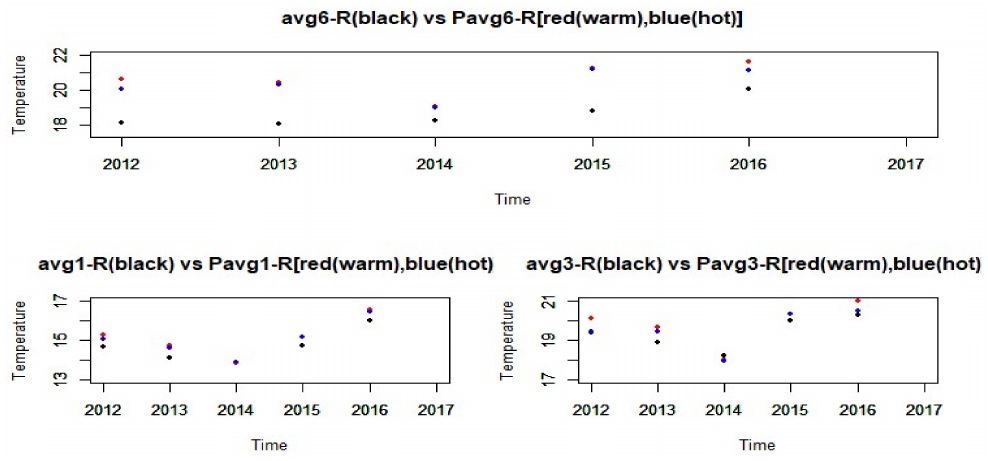
Figure 34. RCP 4.5 warm model (IPSL-CHEM-MR) and RCP 4.5 hot model (MIROC-ESM-CHEM) predictions for the period 2012–2017 (recorded water level), temperature in ◦ C.